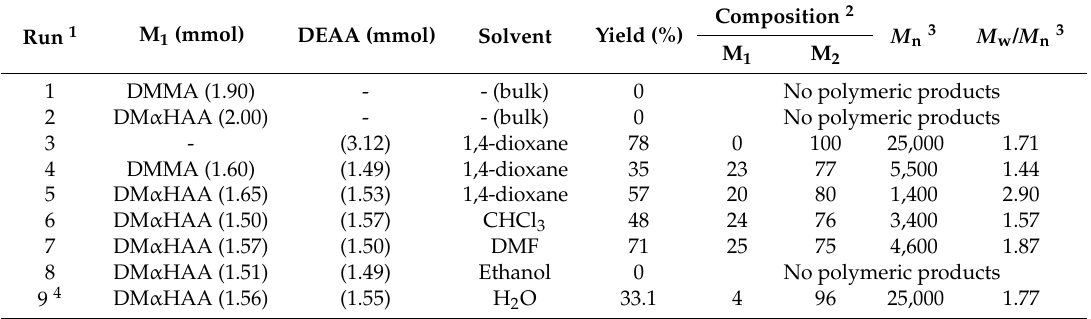
Table 1. Radical (co)polymerizations of DMMA ( N , N -dimethylmethacrylamide) and DM α HAA ( N , N -dimethyl- α -(hydroxymethyl)acrylamide) with DEAA ( N , N